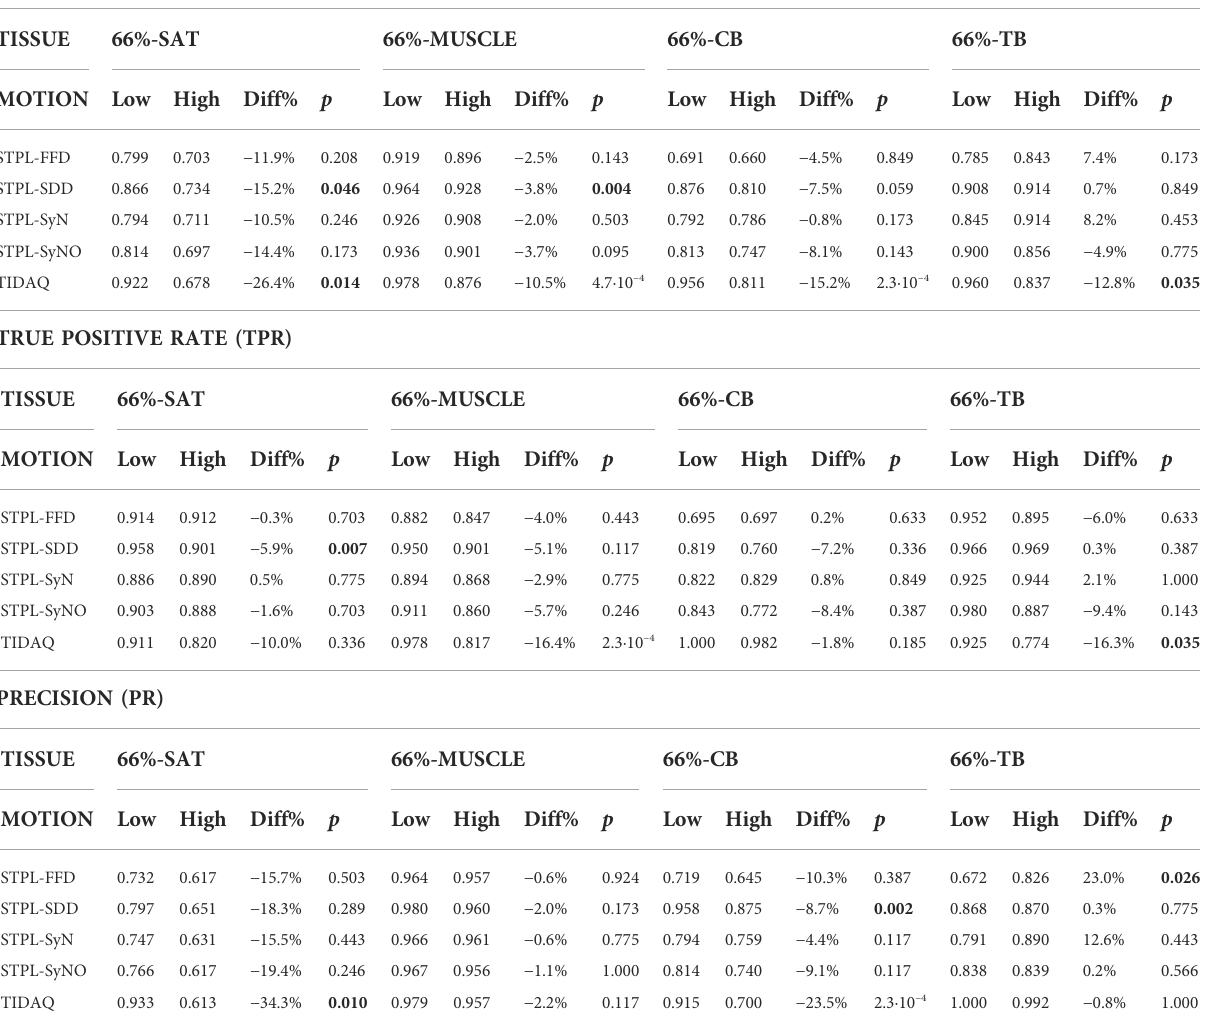
TABLE 10 Effect of motion artifacts on segmentation